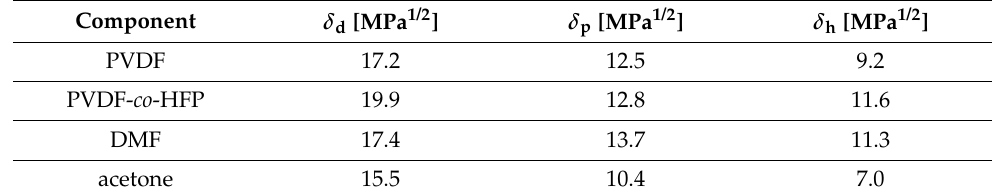
Table 1. Summary of HSP parameters for entry components.